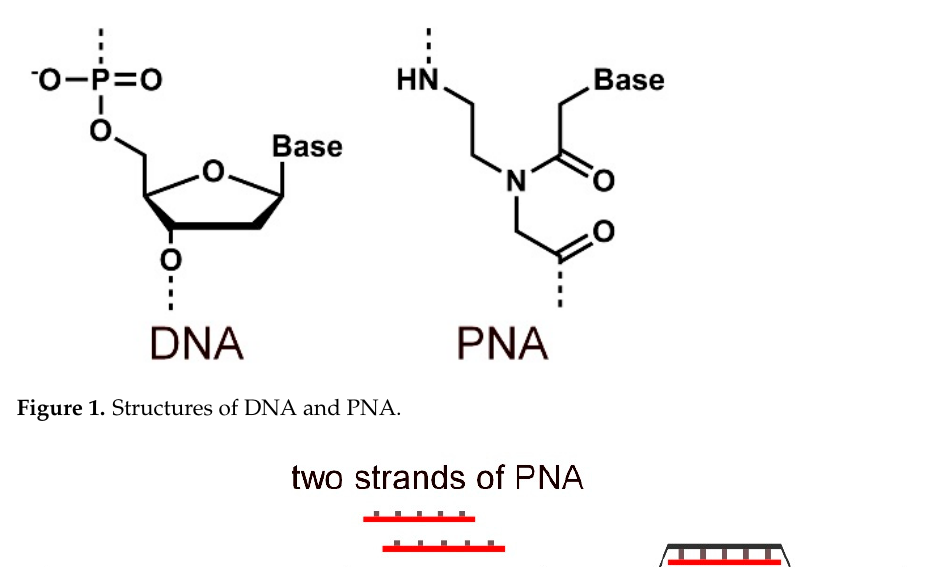
Figure 2. The dsDNA recognition by PNA via double-duplex invasion.